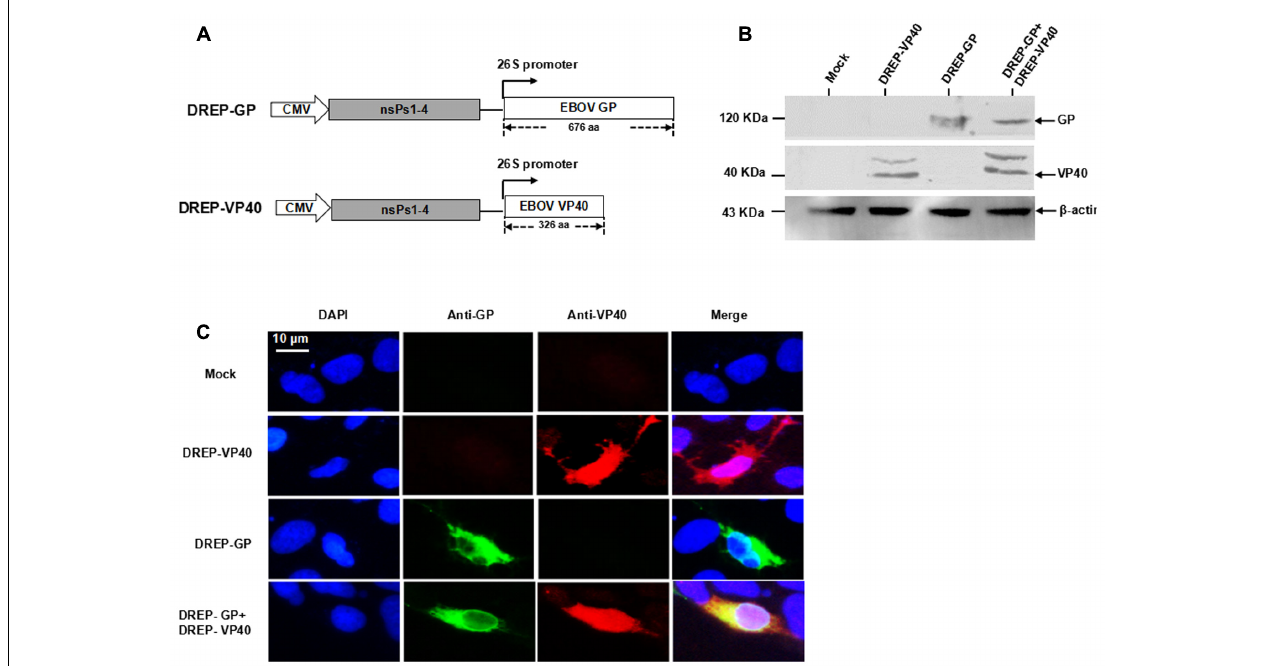
FIGURE 1 | Expression of EBOV GP and VP40 proteins based on SFV DREP vectors. (A) Diagram of constructed recombinant DREP-GP and DREP-VP40 plasmids, nsPs represent the non-structural proteins; (B) Western blot; and (C) Indirect immunofluorescence analysis of GP and VP40 proteins in transfected 293 cells at 48 h post-transfection. β -actin was taken as the internal control in Western blot.